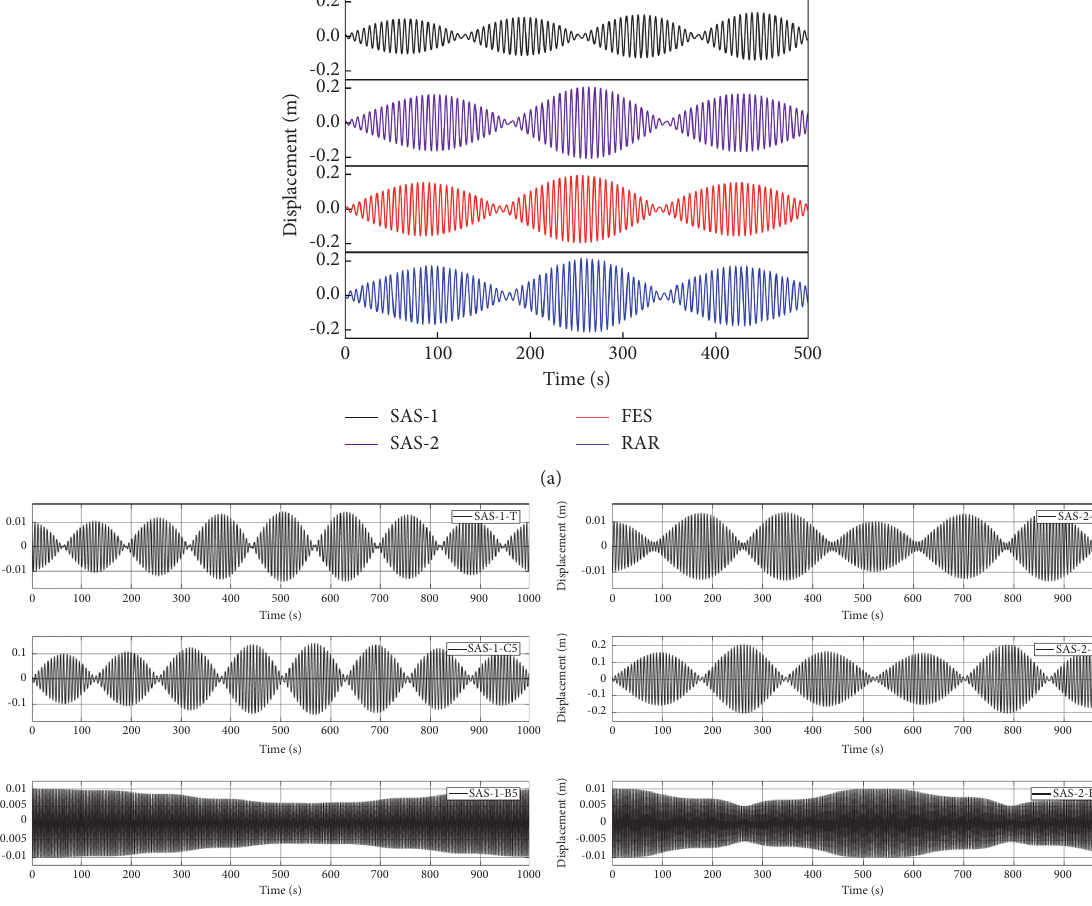
Figure 7: The comparison of calculation results under different conditions. (a) The comparison of different analytical solutions. (b) The comparison of calculation results under different conditions of